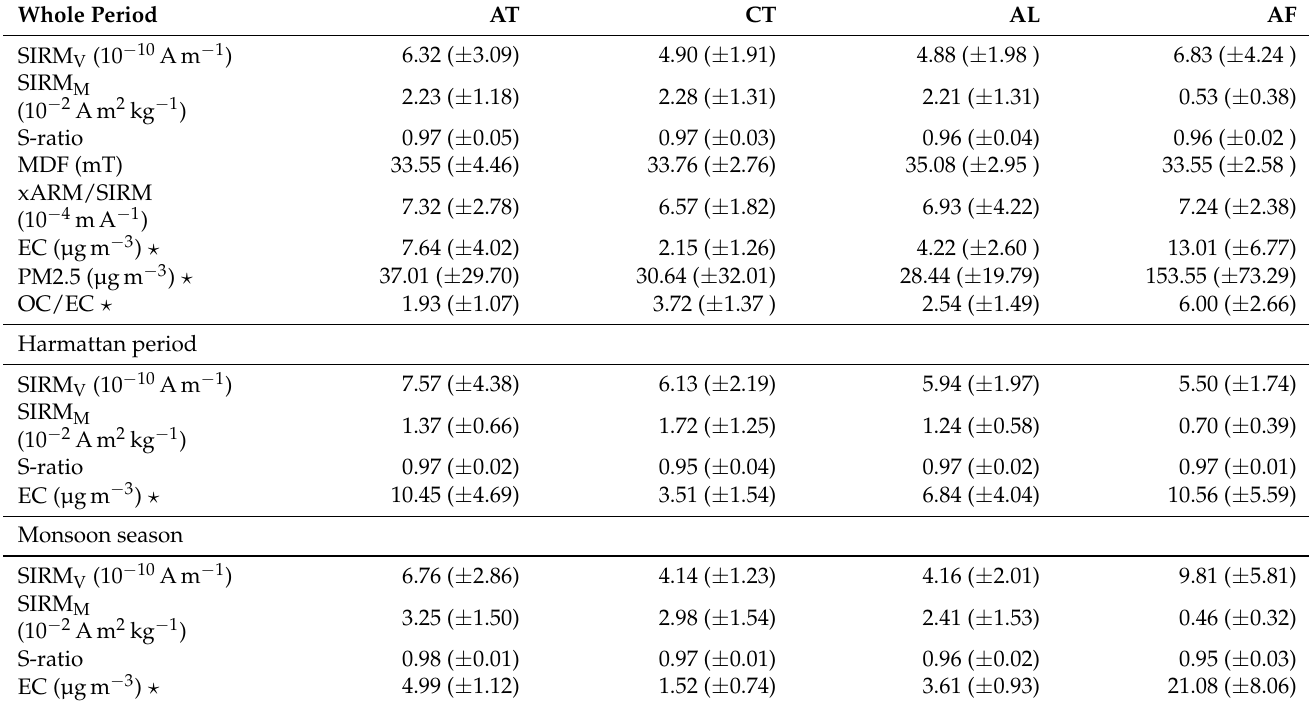
Table 1. Summary of calculated means and standard deviations for the magnetic parameters, concentrations of EC (elemental carbon) and PM2.5 (particulate matter with aerodynamic size below 2.5 µ m), and organic and elemental carbon ratio (OC/EC). SIRM (saturation of the isothermal remanent magnetization) is presented as both mass and volume normalized (SIRM M and SIRM V , respectively) and MDF is the Mean Destructive Field. Stars indicate values from Djossou et al. [18]. Whole Period AT CT AL AF SIRM V (10 − 10 Am − 1 ) 6.32 ( ±